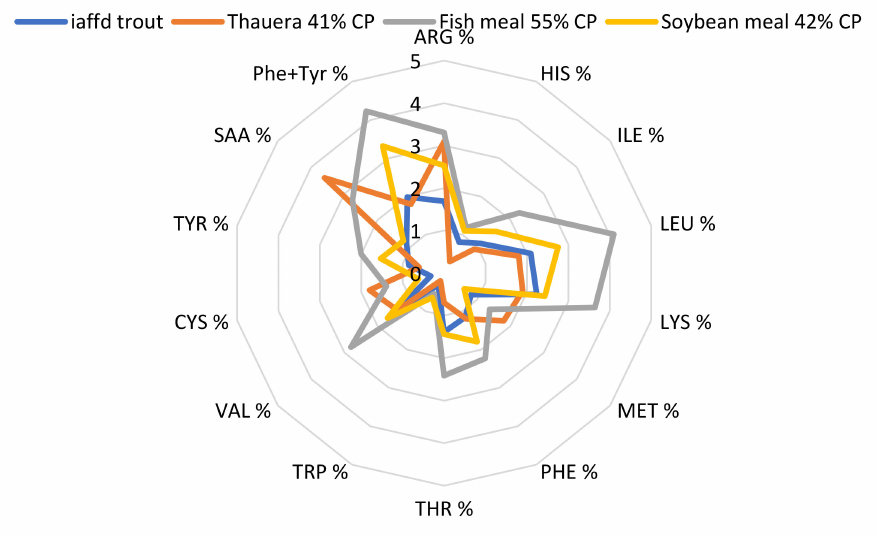
Figure 3. Comparison of the amino acids composition of the PHA enriched biomass compared with the commercial protein source such as soybean and fish meal. The protein content is in relation to the actual demand of amino acids of the trouts. ARG: Arginine; HIS: Histidine; ILE: Isoleucine; LEU: Leucine; LYS: Lysine; MET: Methionine; PHE: Phenylalanine; THR: Threonine; TRP: Tryptophan; VAL: Valine; CYS: Cystine; TYR: Tyrosine; TSAA (Met + Cys): sulfured amino acid; Phe+Tyr: Phenylalanine +